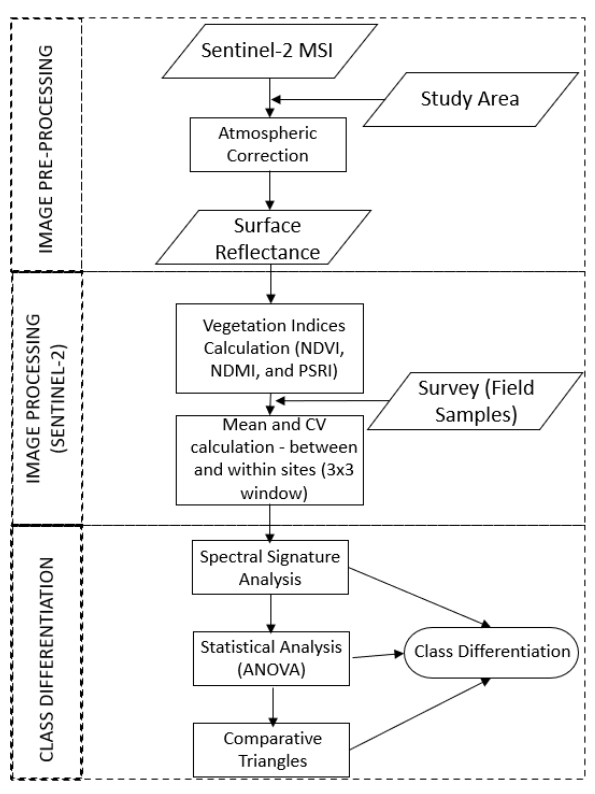
Figure 2. General workflow of the method used in this study.